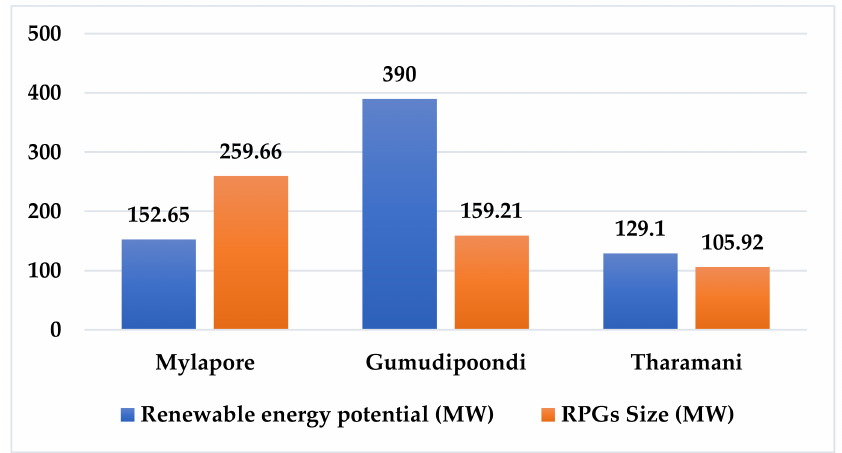
Figure 18. Comparative analysis between potential assessments versus RPGs